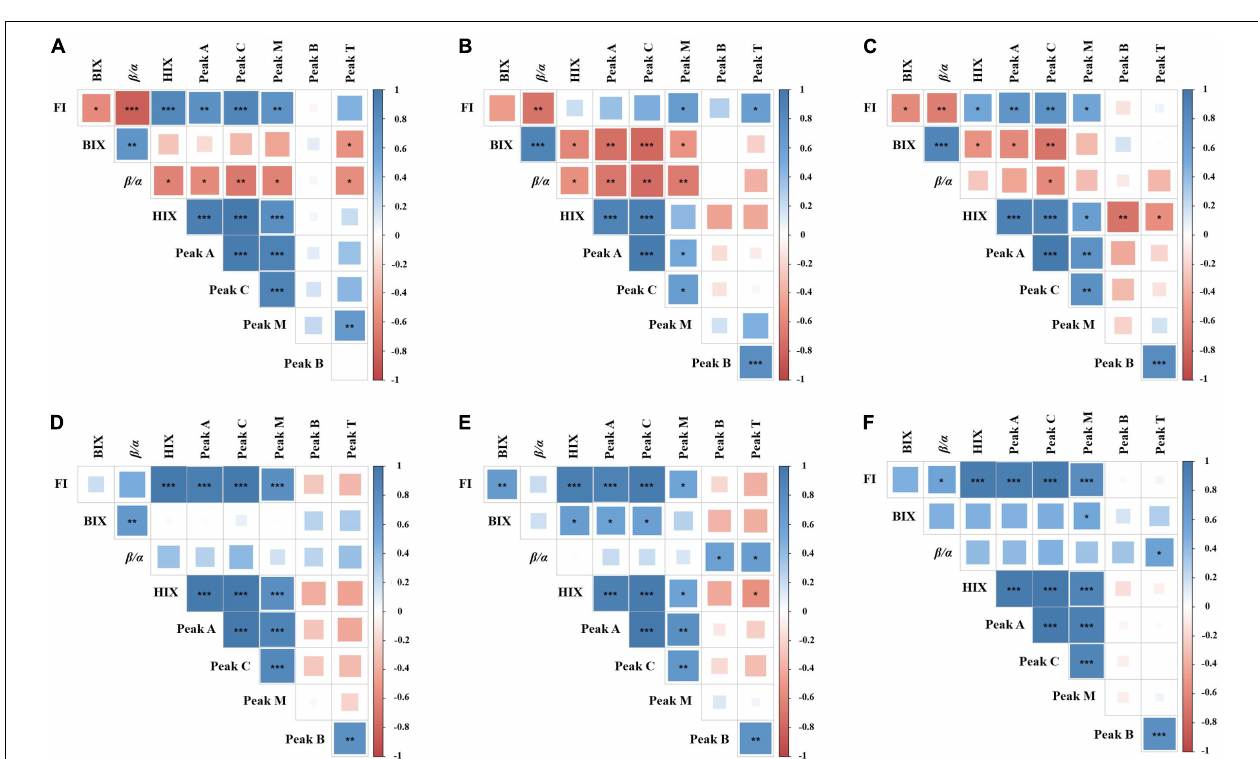
FIGURE 3 | Changes in fluorescence peaks (A–E) and indices (F–I) of three culturable epiphytic bacteria, Roseobacteria sp. , Marinobacter sp., and Bacillus sp. of S. dohrnii in the different OM treatments over the 90-day time period. Error bars represent the standard error for triplicates cultures. Note error bars are smaller than the symbol sizes in some cases. Tukey’s post hoc test were conducted between the DOM and LOM treatments, excluding the blank groups. Asterisk ( ∗ ) represents statistical significance at the p < 0.05. Green and orange asterisk indicate statistical analysis for each experimental day for the DOM and LOM groups, respectively.